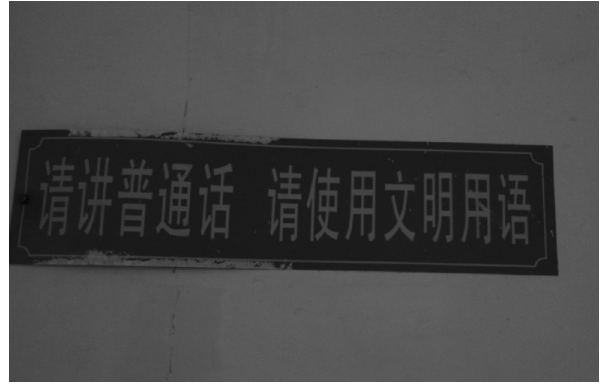
Figure 1: Sign placed on a wall in a school in Ngawa County, part of an autonomously governed district within Sichuan